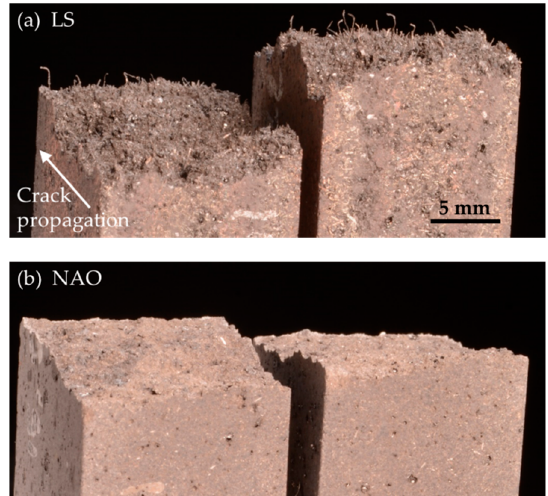
Figure 16. Flexure test samples after rupture: ( a ) LS beam after exposition to heat and flexure test; ( b ) NAO beam after exposition to heat and flexure